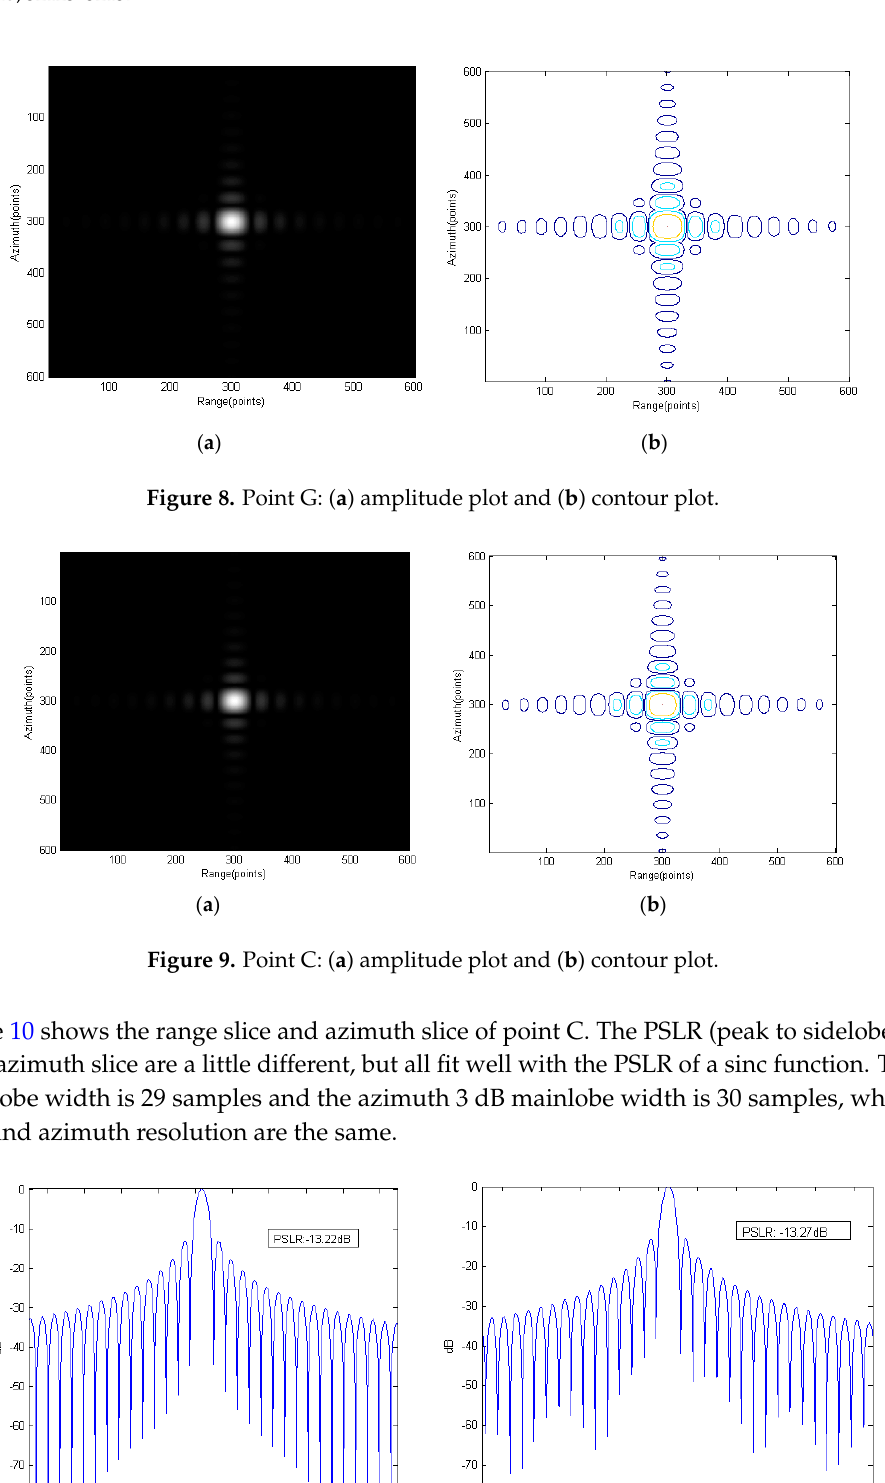
( b ) Figure 11. Spectrum comparison after Stolt mapping: ( a ) traditional Stolt mapping and ( b ) proposed Stolt mapping. Figure 12 shows the compression result using the spectrum of Figure 11a (traditional RMA). A decrease in the image quality can be observed especially from the contour plot.